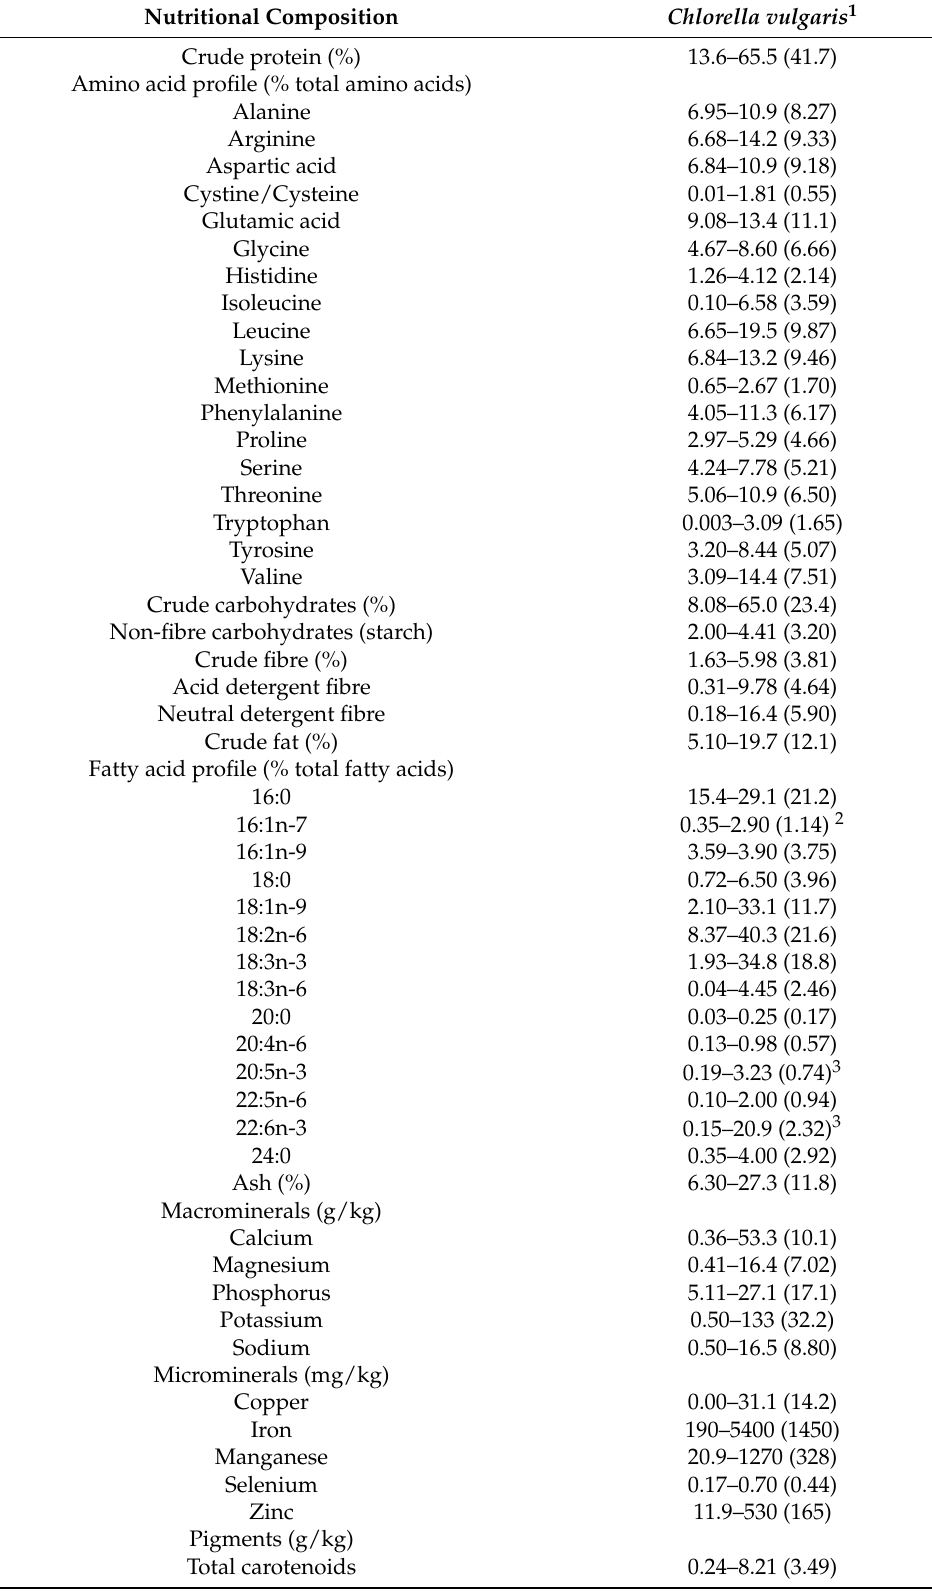
Table 1. Chemical composition of Chlorella vulgaris (all values are expressed on a dry matter basis; hyphenated values are ranges based on several studies and mean values are within